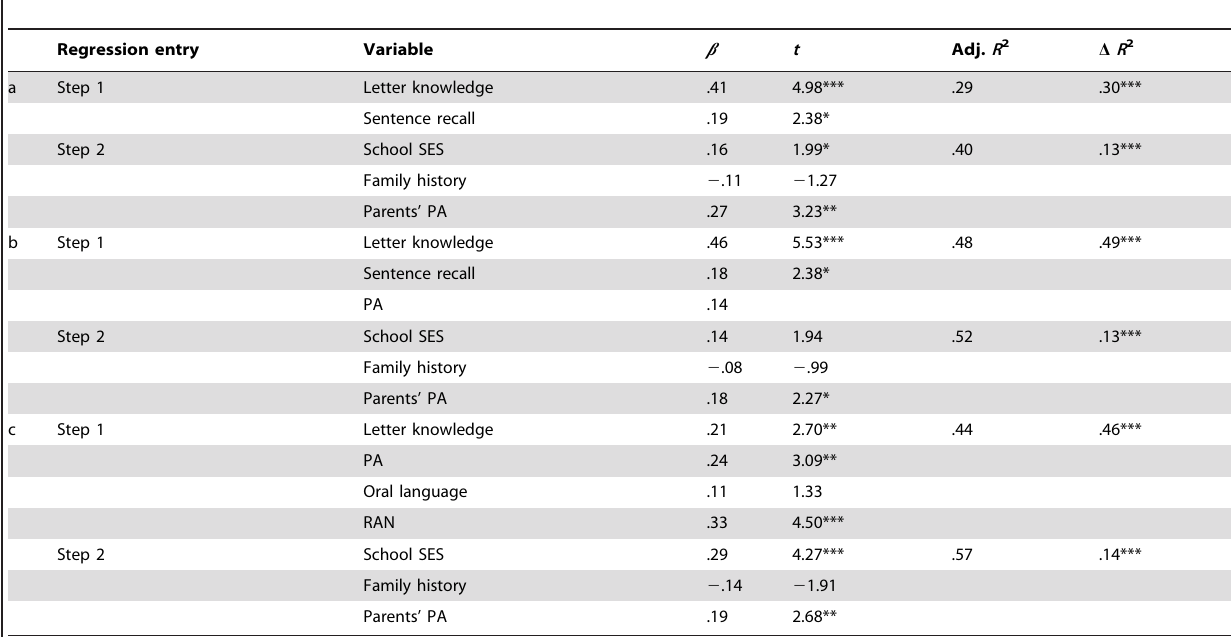
Table 5. a. Hierarchical regression predicting early literacy outcomes from family and child risk factors at T1; b. Hierarchical regression predicting early literacy outcomes from family and child risk factors at T2; c. Hierarchical regression predicting early literacy outcomes from family and child risk factors at